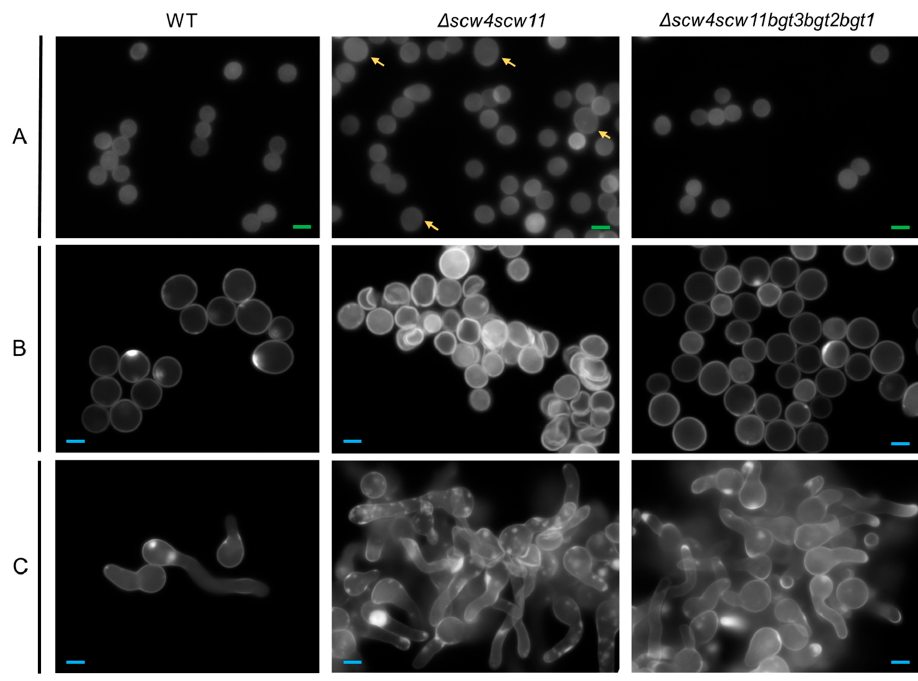
Figure 4. Morphology of the dormant ( A ) 0 h; swollen ( B ) 4 h; and germinated ( C ) 8 h conidia of the parental strain, and Δ scw4 Δ scw11 and Δ scw4scw11bgt3bgt2bgt1 mutants using fluorescence microscopy (×63) with UV light and Calcofluor white ® staining, in 3% Glucose medium +1% yeast extract. Green scale bars (2 µm in panel A), blue scale bars (6 µm in B and C), and yellow arrows highlight dormant conidia with abnormal size.